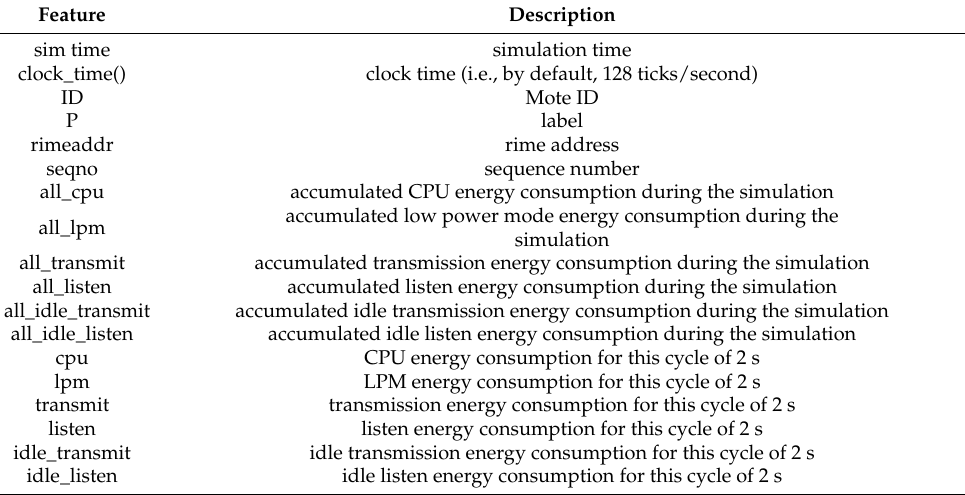
Table 4. Features and respective descriptions of the “benign powertrace” dataset and the “malicious powertrace”